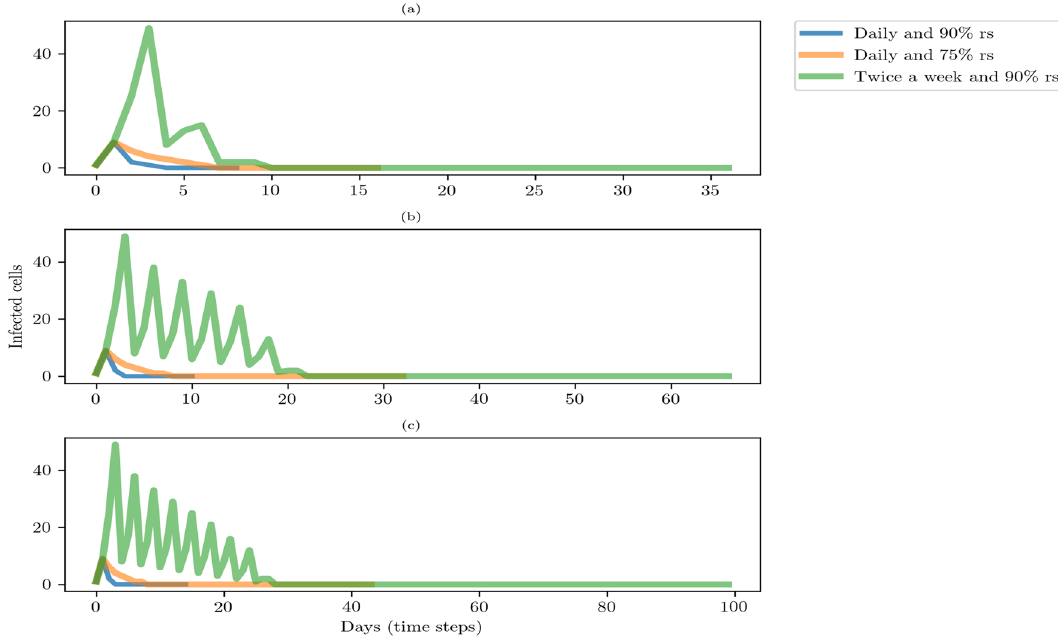
Figure 3. Trajectories of infected cells and number of days to control and stop the virus transmission. The computation of trajectories was based on the median of 10,000 model executions. ( a ) Array size of (10,10), ( b ) array size of (30, 30), and ( c ) array size of (60,60). Percentage of random sample (%